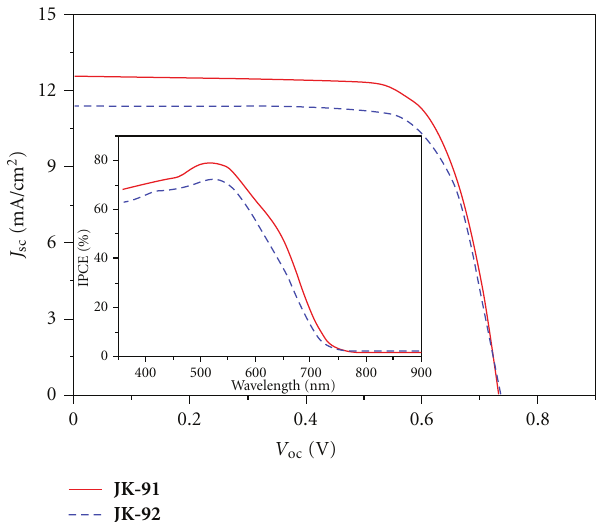
Figure 25: I-V curves and IPCE spectra for JK-91 and JK-92 (taken from [42]).